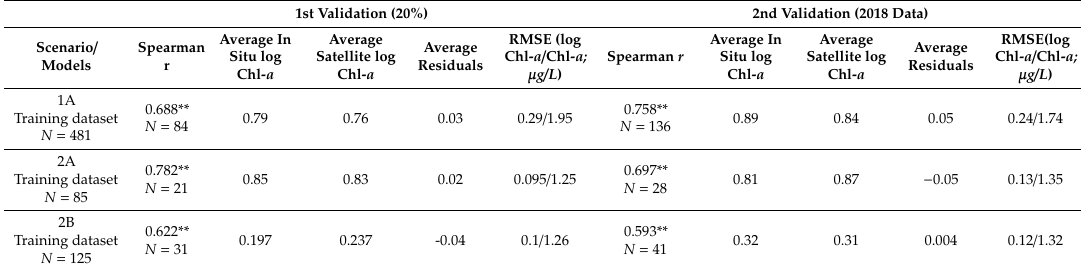
Table 10. Statistical indices used to validate the selected algorithms (correlation significant ** at the 0.01 level (two-tailed) and * at the 0.05 level (two-tailed)). RMSE—root-mean-square